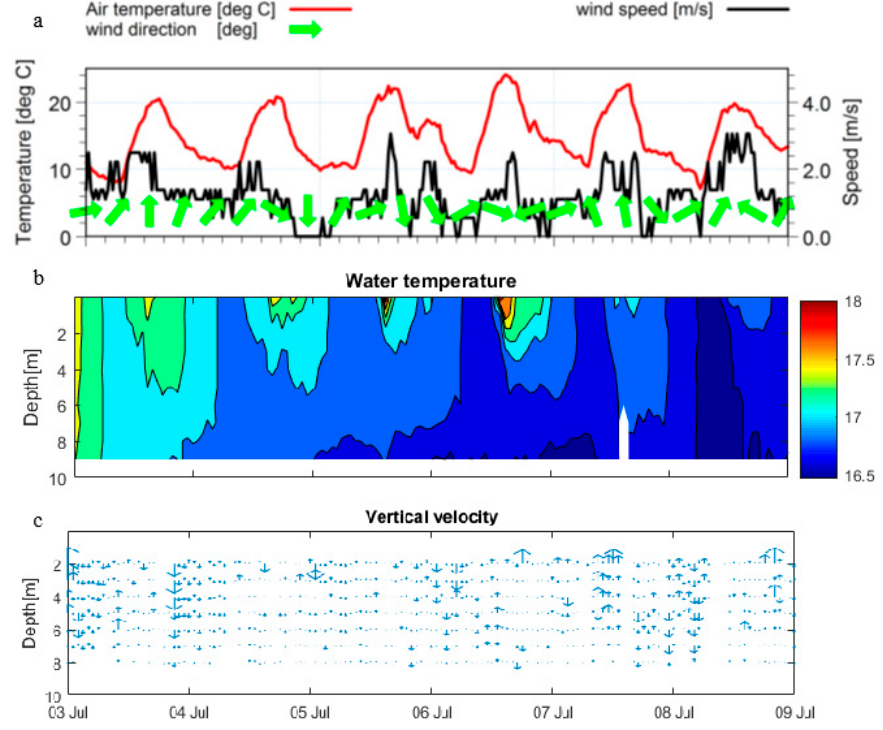
Figure 3. Time series of ( a ) air temperature and wind conditions; ( b ) the vertical profile of water temperature; ( c ) vector plot vertical velocity for the top 9 m in winter from 3 July 2015 to 9 July 2015 for Tingalpa Reservoir.